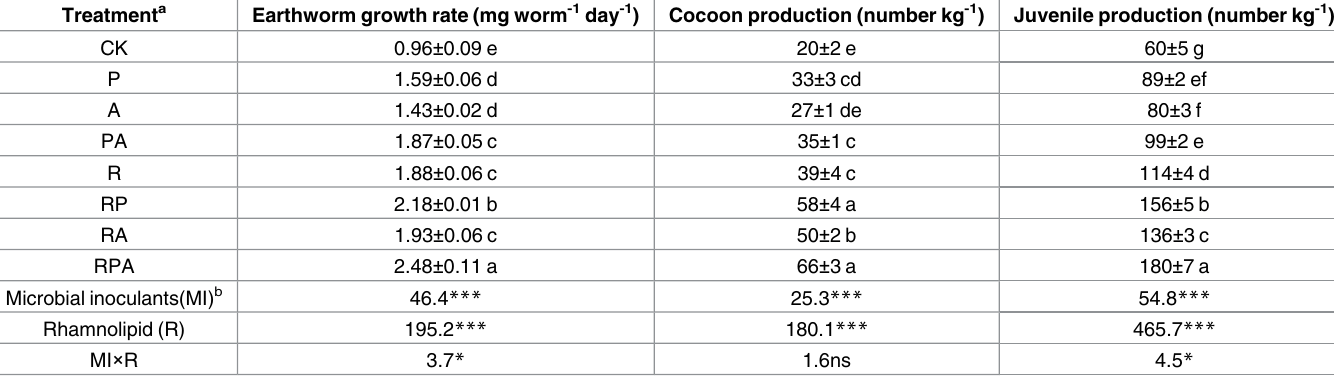
Table 1. Effects of the microbial inoculants and rhamnolipid on the growth and reproduction of the earthworm Eisenia fetida . Treatment a Earthworm growth rate (mg worm -1 day -1 ) Cocoon production (number kg -1 ) Juvenile production (number kg -1